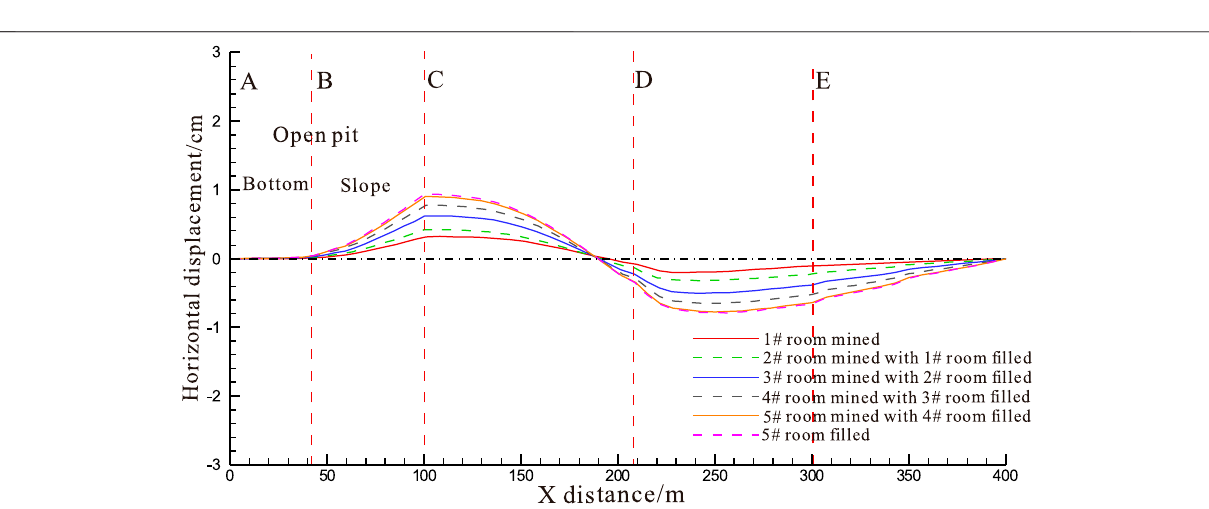
FIGURE 16 | Horizontal displacement curves of the surface as pillar mining and back fi lling in